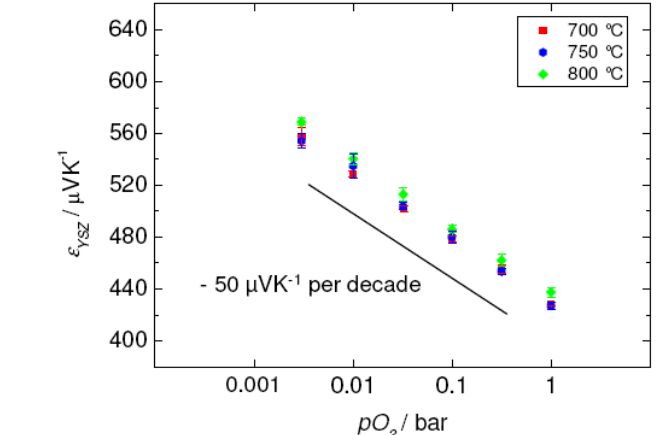
Figure 6. Sensor signal vs oxygen partial pressures for three different temperatures. Please note the very low temperature dependency. Figure adapted from [54]. Reprinted from [54] with permission from